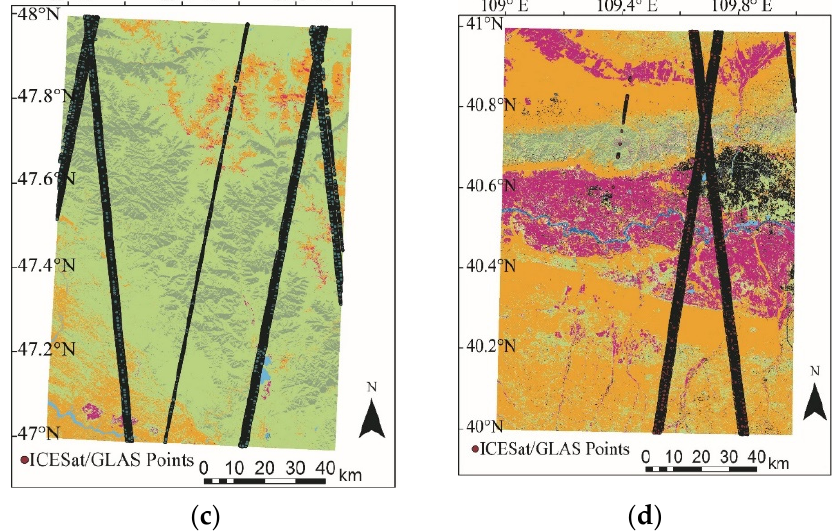
Figure 9. The spatial distribution of land cover in four study areas and the distribution of ICESat/GLAS points: ( a ) Sichuan;